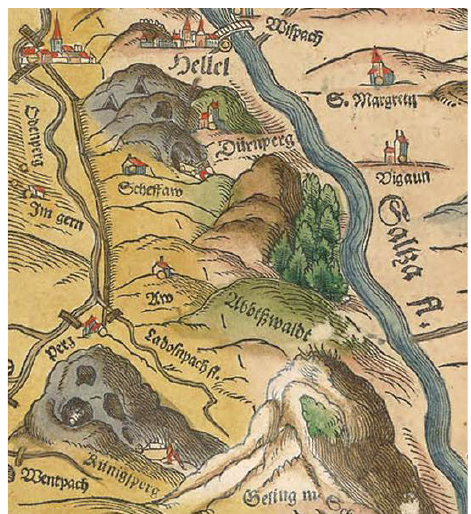
Fig. 2. Entrances to ore mines on sheet no.